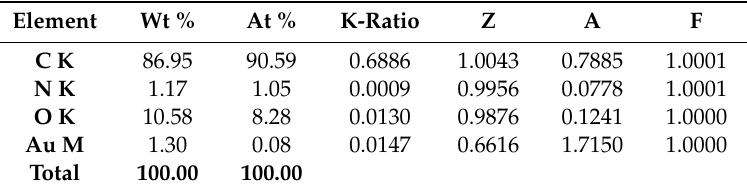
Table 1. Elemental composition of EM2 [29].